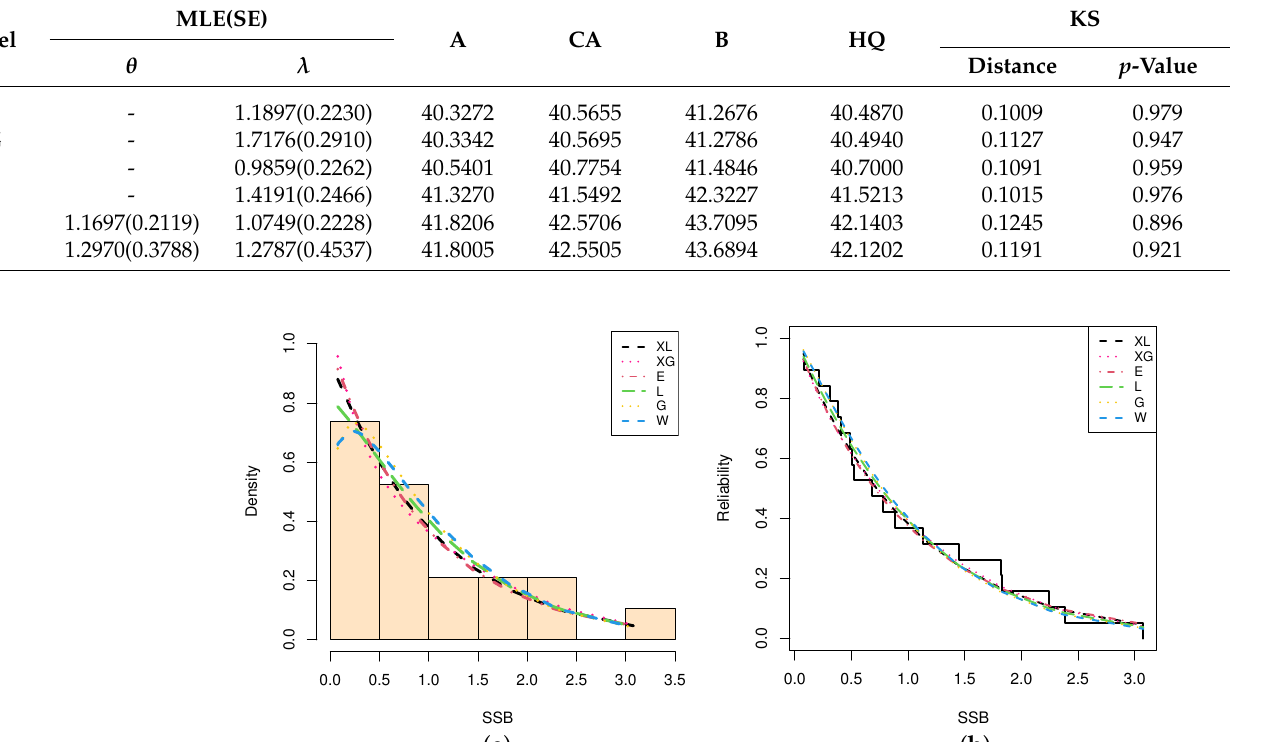
Figure 8. Fitted XL and competing models from SSB data. ( a ) PDFs. ( b )